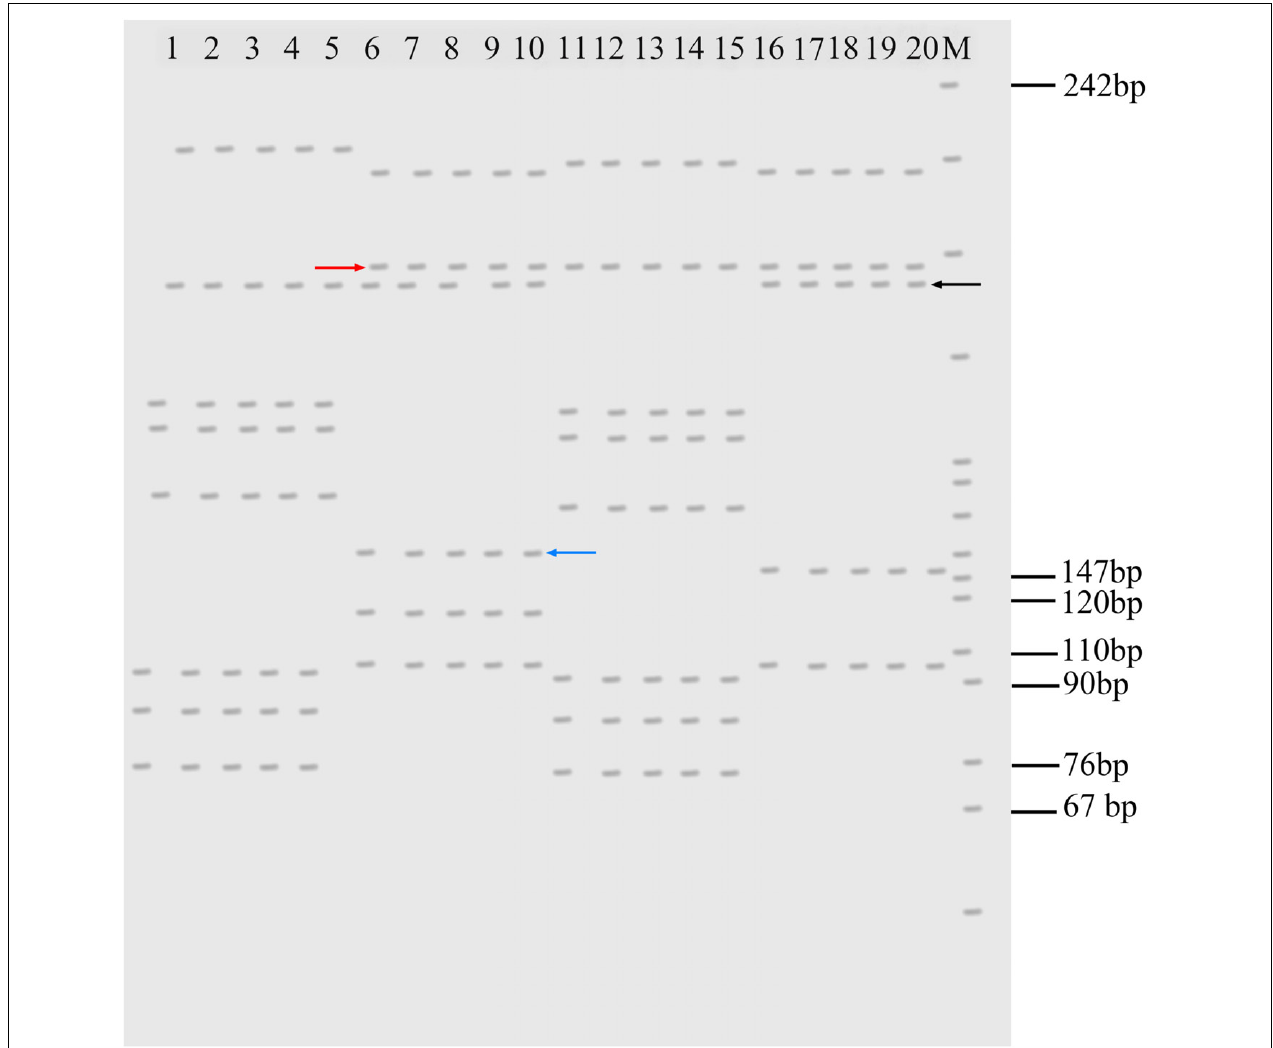
FIGURE 4 | Electrophotogram of microsatellite DNA patterns produced by the primer MFW2 in KOC, RCC-L, BSB, and GF-L. Lanes 1–5 represent KOC. Lanes 6–10 represent RCC-L. Lanes 11–15 represent BSB. Lanes 16–20 represent GF-L. The black arrow indicates the DNA bands derived from KOC. RCC-L and GF-L commonly had this type of band, but BSB did not have this band. The red arrow indicates the DNA bands derived from BSB. RCC-L and GF-L commonly had this type of band, but KOC did not have this band. The blue arrow shows the band found only in RCC-L. M represents the pBR322 DNA/Mspl